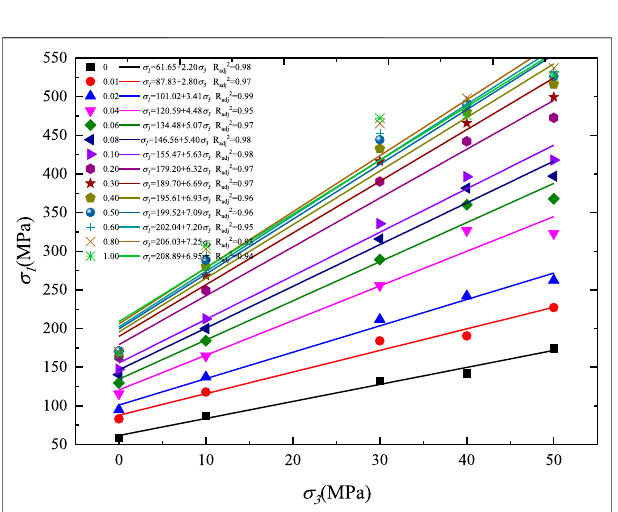
FIGURE 7 | Relationship between σ 1 and σ 3 under different ε D cv curves.